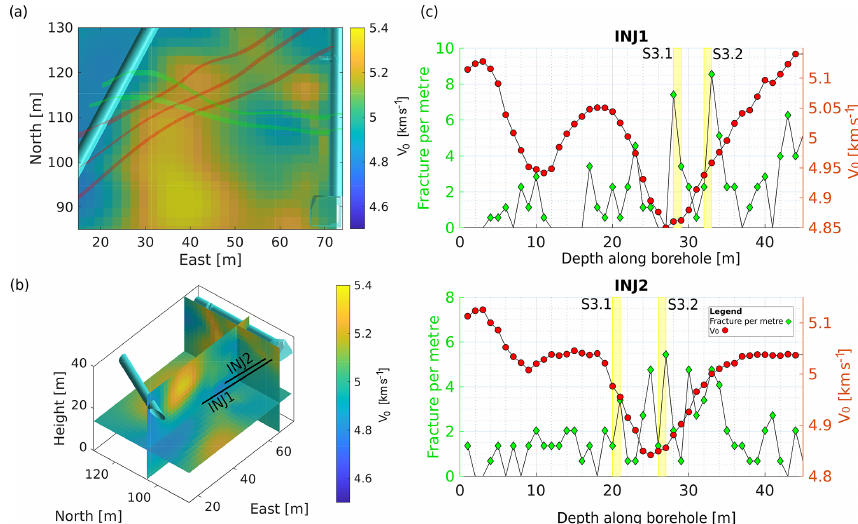
Figure 10. Results of the 3-D velocity inversion. Panels (a) and (b) show slices through the 3-D v 0 volume, along with the interpolated shear zones and the boreholes shown in panel (c) . The horizontal cut in panel (a) is extracted 1m below tunnel level. Panel (c) shows the velocity extracted from the 3-D volume along the trajectories of two boreholes along with the fracture count per metre. One can observe a decrease of velocity near the S3 shear zones and where fracture density is